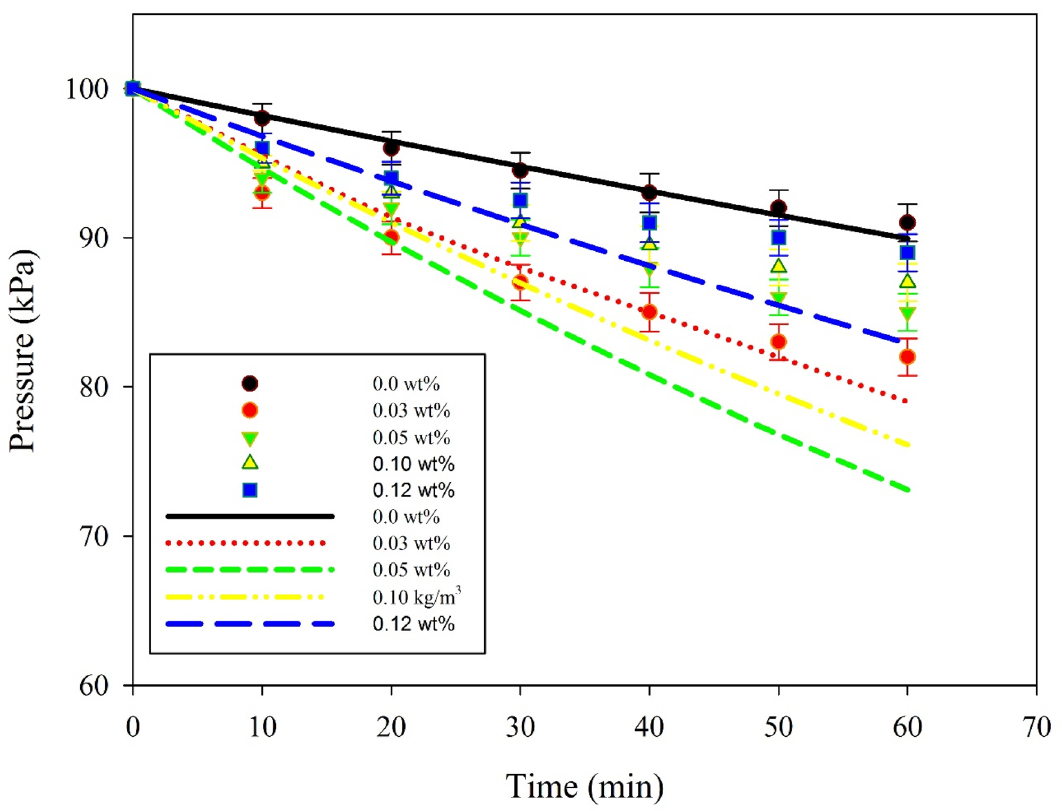
Figure 2. Comparison of experimental data and model predictions for the pressure of CO 2 versus time for different TiO 2 loading, particle size 10 nm nanoparticle and 25 °C temperature. The solid lines represent the model predictions. Mixing rate 120